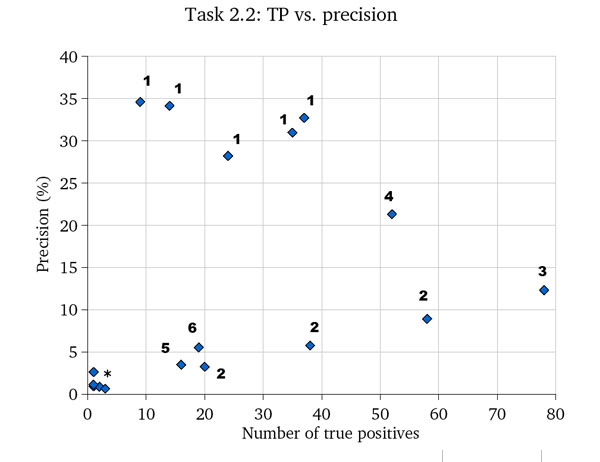
Task 2.2 Precision versus total true positives plot. Task 2.2 results: Precision vs. total number of True Positives. Each point represents a single run submitted by the participants of task 2.2. User 1: Chiang et al., 2: Couto et al., 3: Ehrler et al., 4: Ray et al., 5: Rice et al., 6: Verspoor et al., *: the remaining runs, refer to table 5.